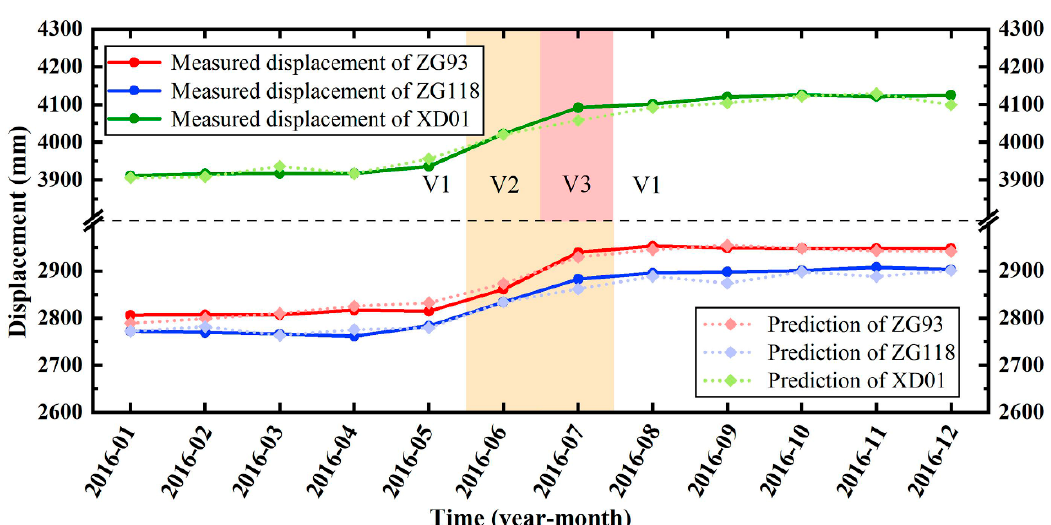
Figure 18. Measured and predicted displacements of ZG93, ZG118, and XD01.